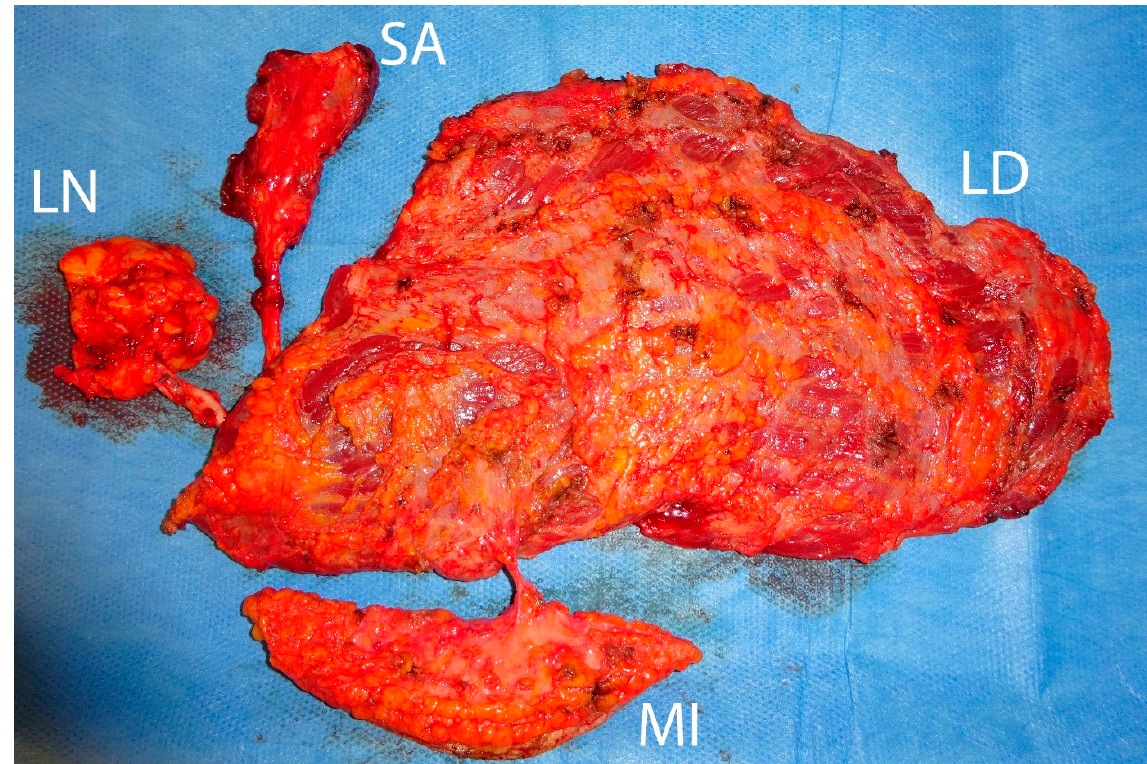
Figure 2. Raised compound flap consisting of a latissimus dorsi muscle flap (LD), a serratus anterior muscle flap (SA), a perforator-based monitor flap (MI), and a thoracodorsal lymph node flap (LN).